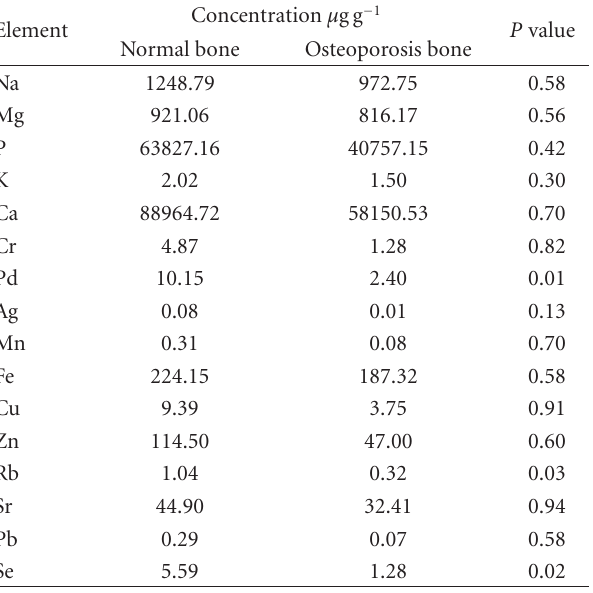
Table 2: Average of atomic mineral concentrations which is lower in osteoporosis bone.